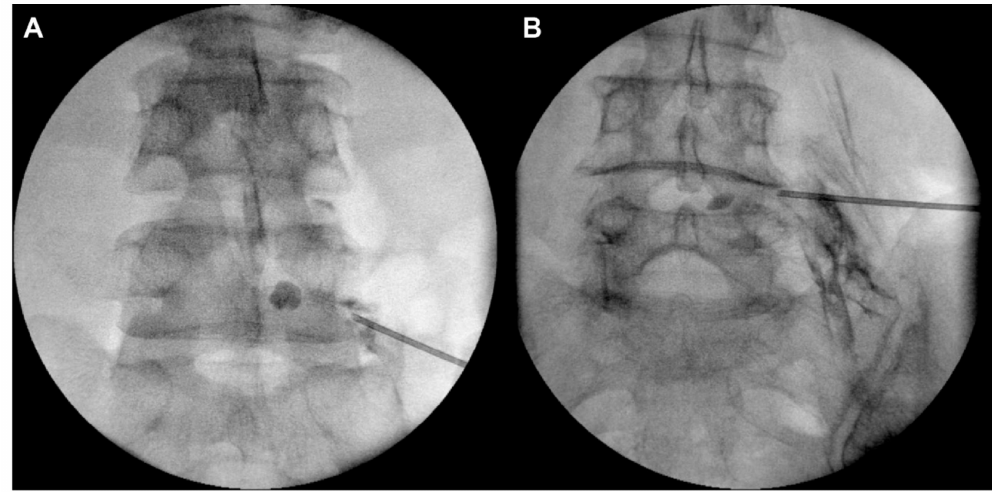
Figure 2. Fluoroscopic anterior-posterior view of the safe-triangle approach ( A ) and the Kambin’s-triangle approach ( B